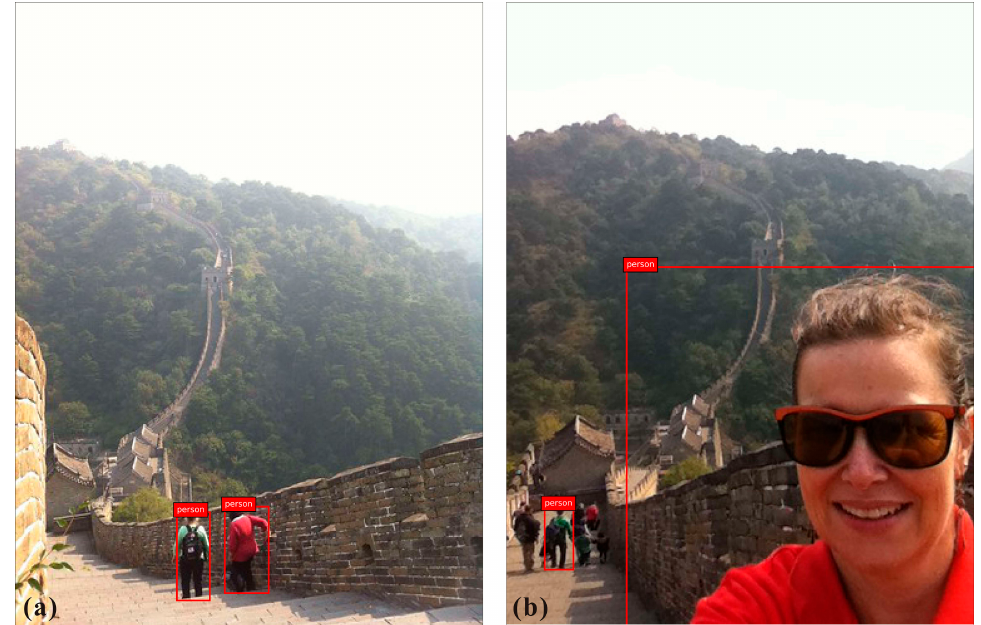
Figure 3. Examples of ( a ) small proportion and ( b ) large proportion that detected humans occupy in images (Figure 3a and Figure3b were drawn the object detection boxes, and are both licensed